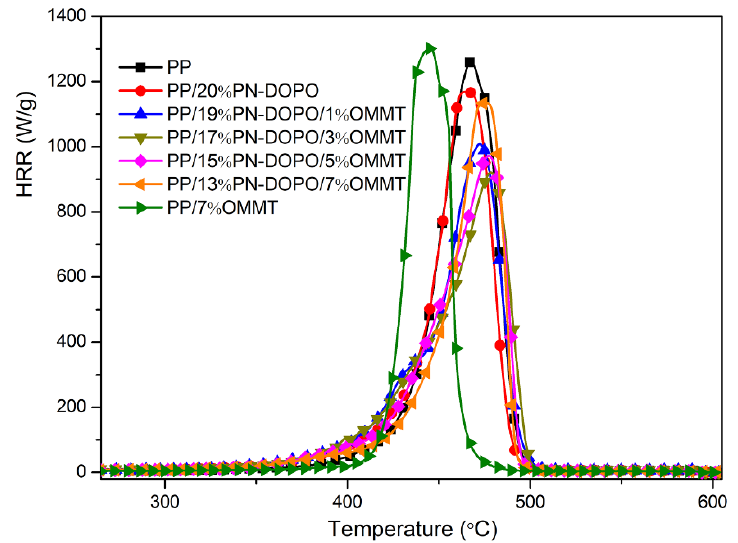
Figure 2. Heat release rate curves of PP and flame-retarded PP composites measured by MCC tests.